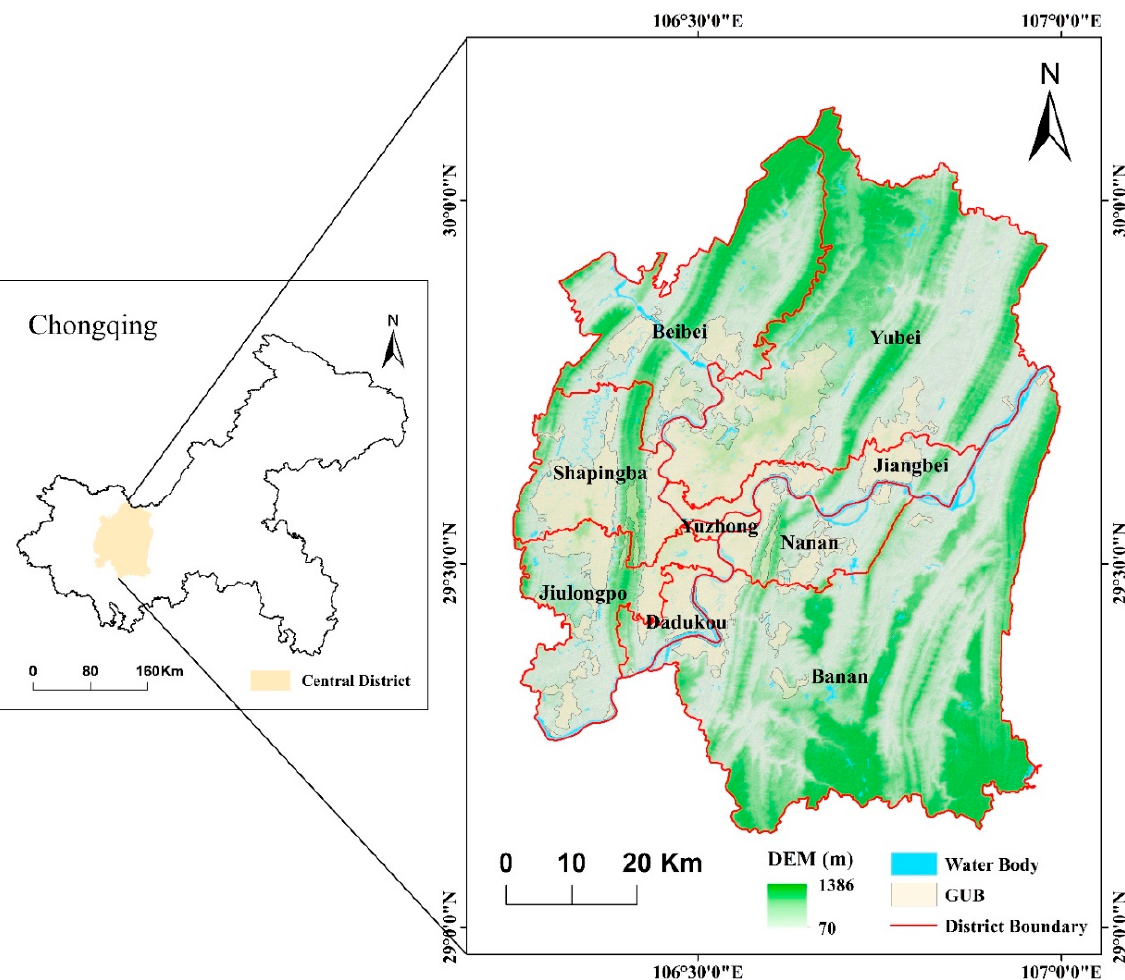
Figure 1. Location of the study area (DEM: digital elevation model; GUBs: global urban bounda- ries).